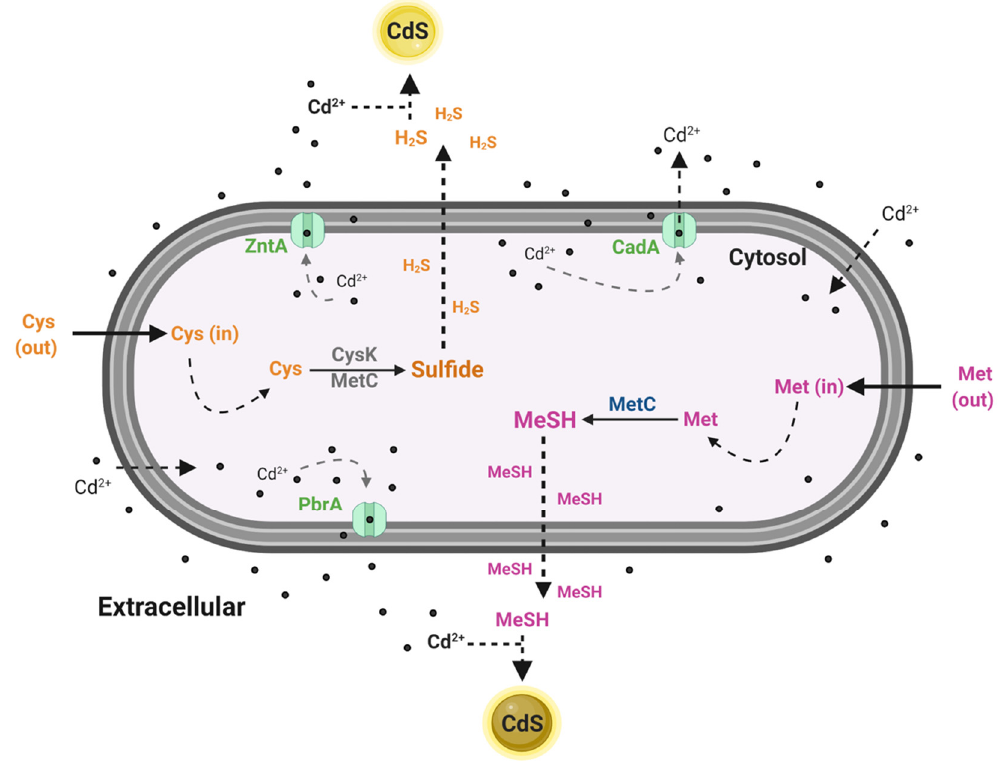
Figure 8. Schematic representation of the CdS QDs biosynthesis by Pseudomonas sp. GC01. The figure shows the proteins present in the Pseudomonas sp. GC01 genome involved in the biosynthesis of CdS nanoparticles when Cys (CysK and MetC) or Met (MetC) was used as the sulfur source as well as the Cd 2+ efflux pumps CadA, ZntA, and PbrA.